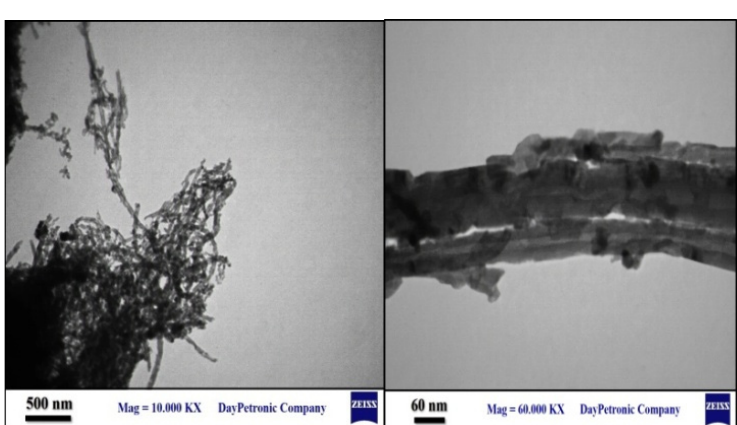
Fig. 1. XRD of (MWCNTs)-COOH/La 2 O 3 nanocomposite [15]